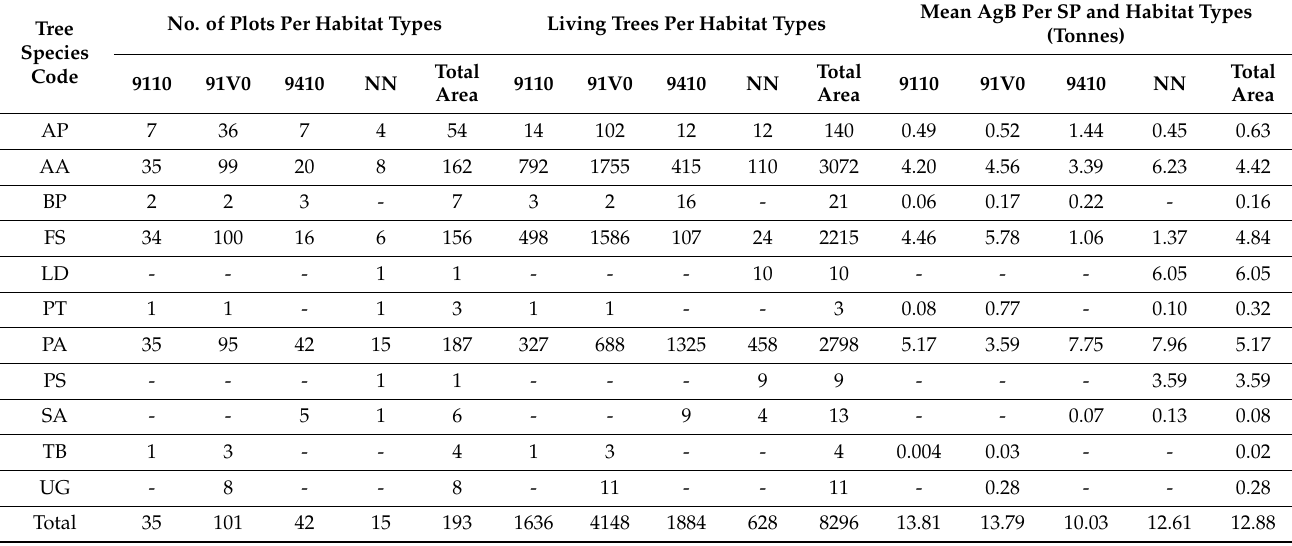
Table 2. Summary data regarding the tree species and forest habitats within the Sl ă tioara-Rar ă u area. No. of Plots Per Habitat Tree Species Code